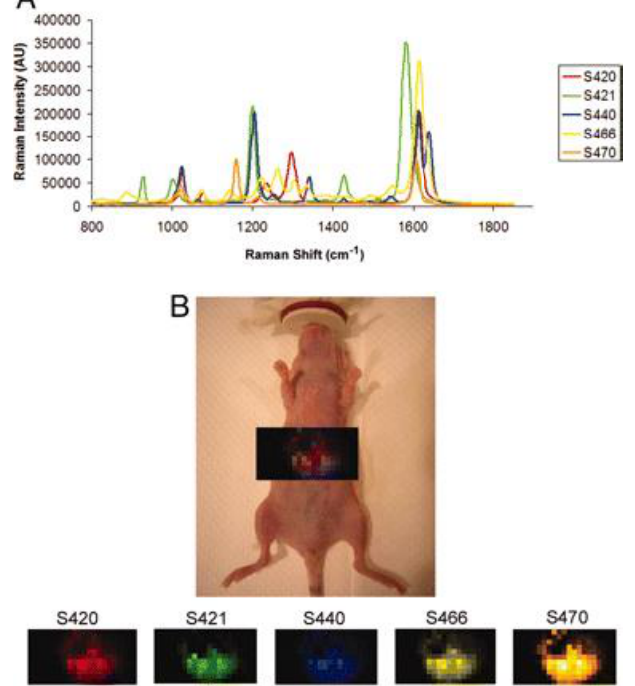
Figure 7. ( A ). Raman spectra of Raman reporters. ( B ). in vivo imaging of mouse liver after simultaneous injection of SERS nanotags with five different Raman reporters. Redrawn from Figure 3 [210] with permission from PNAS.